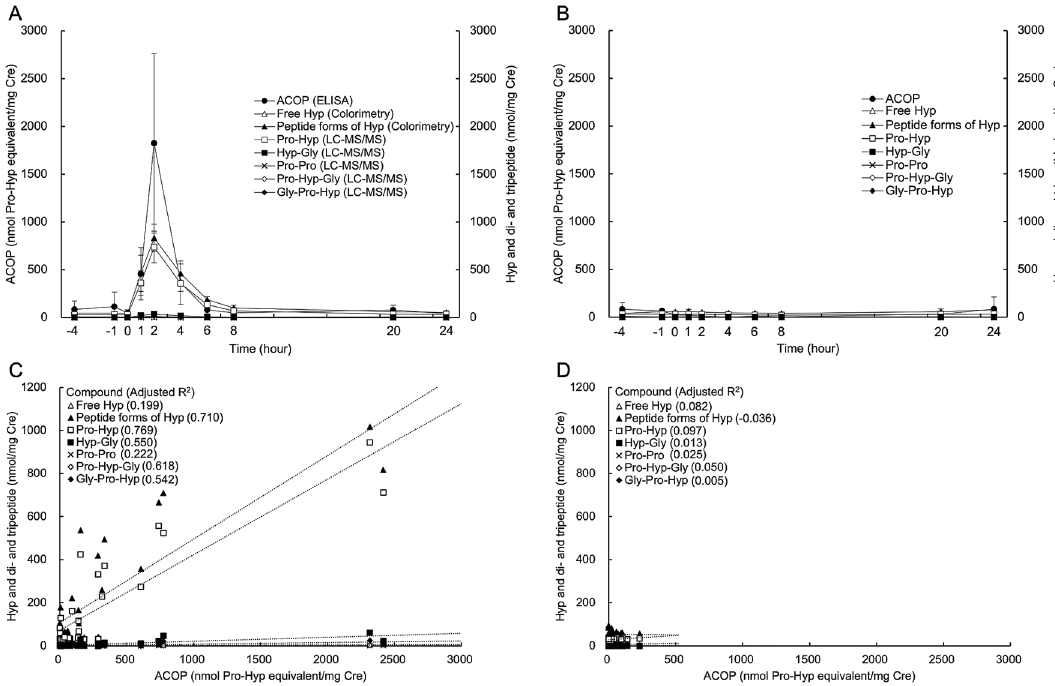
Figure 2. Urinary levels of collagen-derived metabolites after CP ingestion. Time course of collagen-derived metabolite levels in the group of CP ingestion ( A ) and control ( B ). Correlation between ACOP and each collagen-derived metabolite in the group of CP ingestion ( C ) and control ( D ). Samples were measured using colorimetry for free Hyp and peptide forms of Hyp; LC–MS/MS for Pro-Hyp, Hyp-Gly, Pro-Pro, Pro-Hyp-Gly, and Gly-Pro-Hyp; and ELISA for ACOP. Each symbol represents the mean concentration and the bar represents the standard deviation (n = 3, Mean ± standard deviation). The time course consisted of 10 time points over 24 h, with the time of CP ingestion as the 0 h. − 4 and 20 h were defined as the first early morning urine. Dotted lines in C and D indicate the regression lines for the concentration of each compound, and the adjusted coefficient of determination (adjusted R 2 ) at upper left corner. The amount of ACOP was calculated as Pro-Hyp equivalents. Creatinine level was used to correct for variability in concentrations of urinary